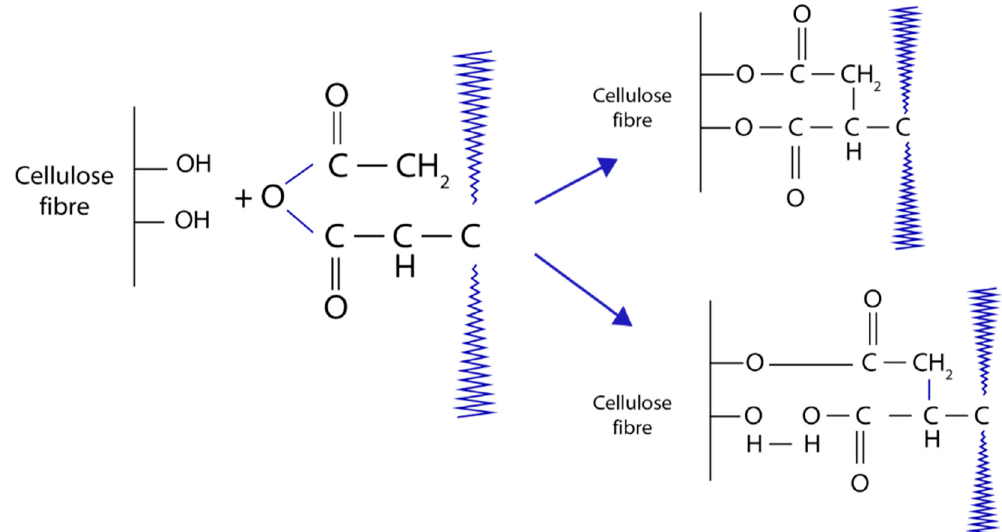
Figure 11. Second method of treatment of cellulose fibers with MAPP copolymer.